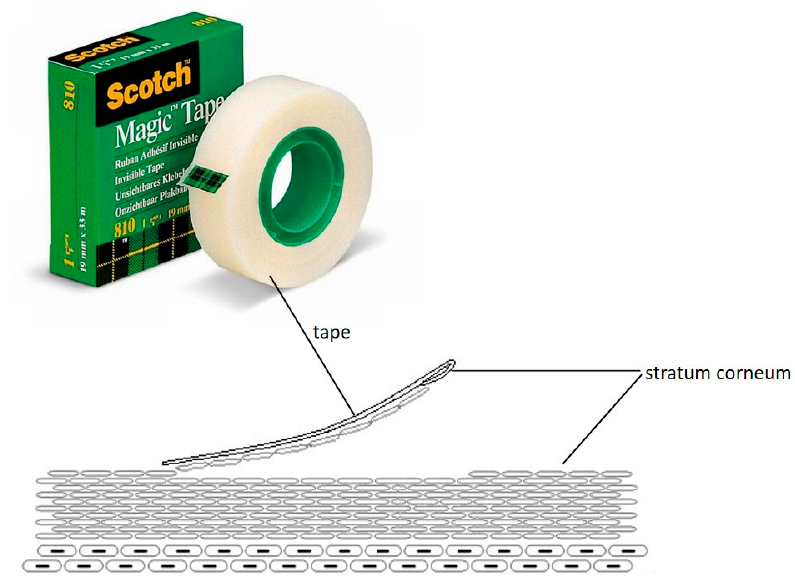
Figure 13. Tape stripping method.